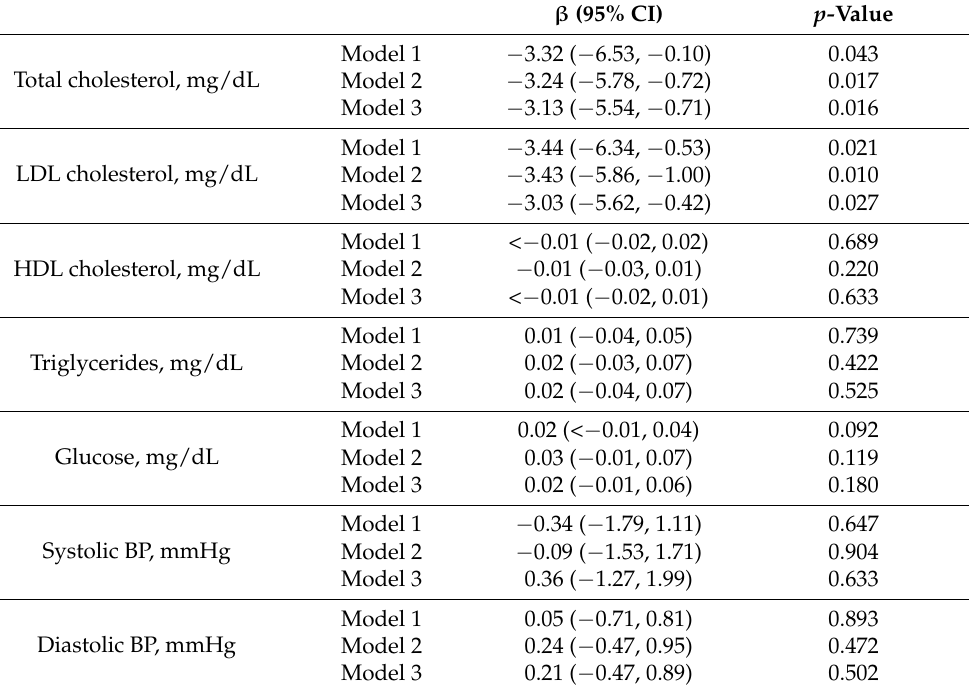
Table 3. Association between biochemical variables and blood pressure and urinary tartaric acid ( µ g/mg